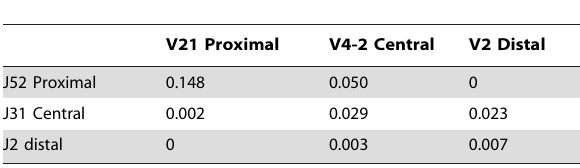
Table 5. V-J association probabilities along the TRA locus.